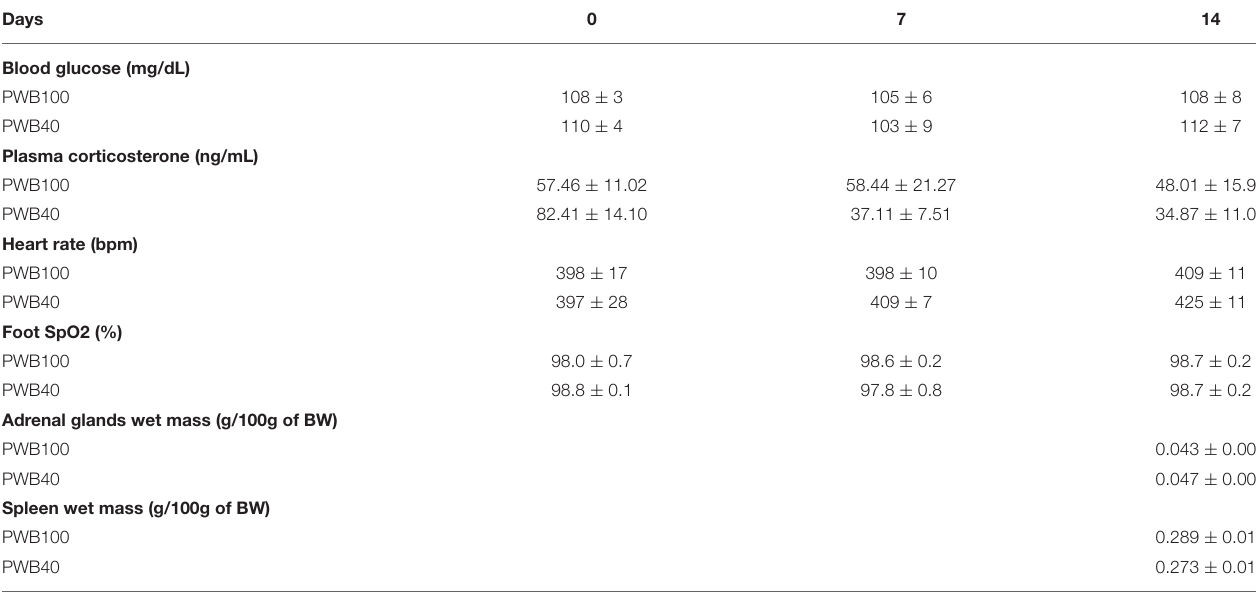
TABLE 1 | Weekly measurement of plasma parameters, foot oxygenation, and heart rate; and wet mass of the adrenal glands and spleen after 14 days of PWB. Days 0 7 14 Blood glucose (mg/dL)